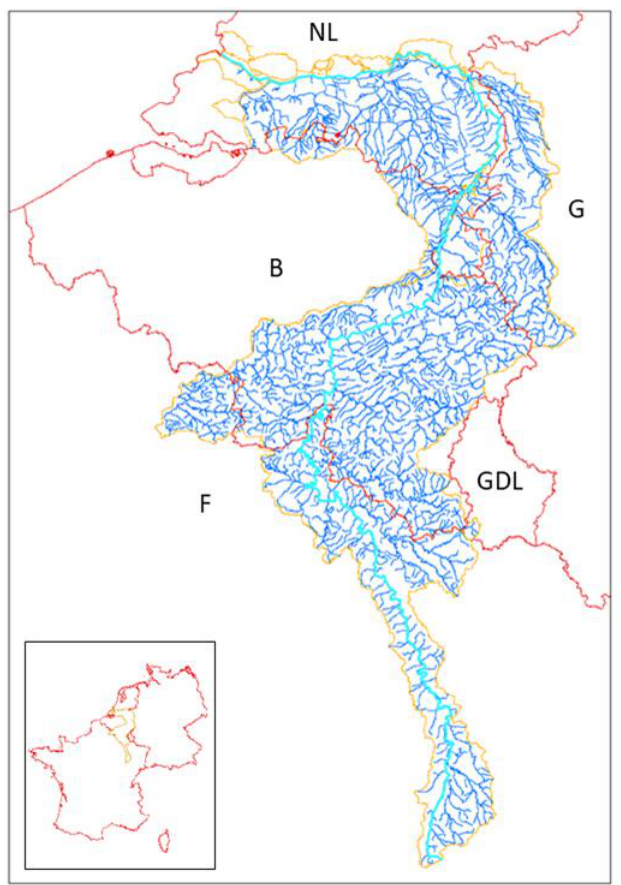
Figure 1. Map of the International River Basin District of the Meuse (France (F), Belgium (B), GD Luxembourg (GDL), Germany (G), the Netherlands (NL)). The Meuse River is marked in a light blue line, deep blue lines represent tributaries, red lines are the borders and yellow line is the International River Basin District boundary.